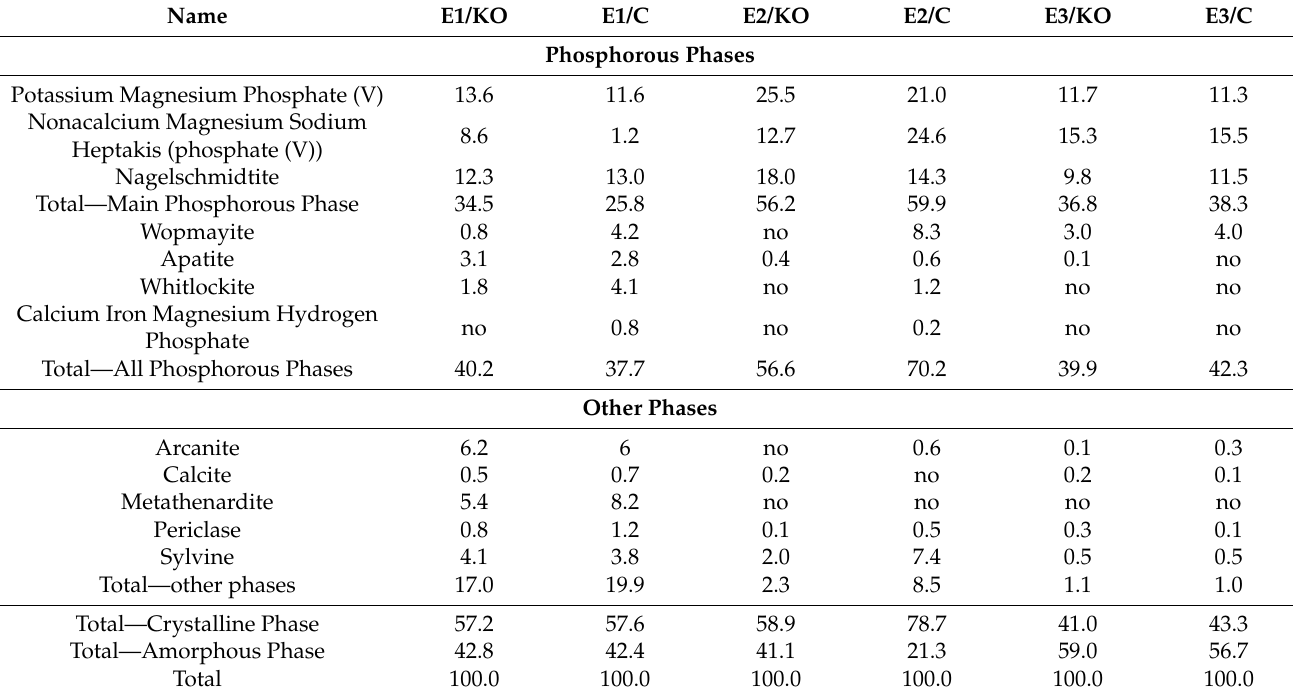
Table 7. Phase composition (wt. %) of ashes from poultry manure using the XRD